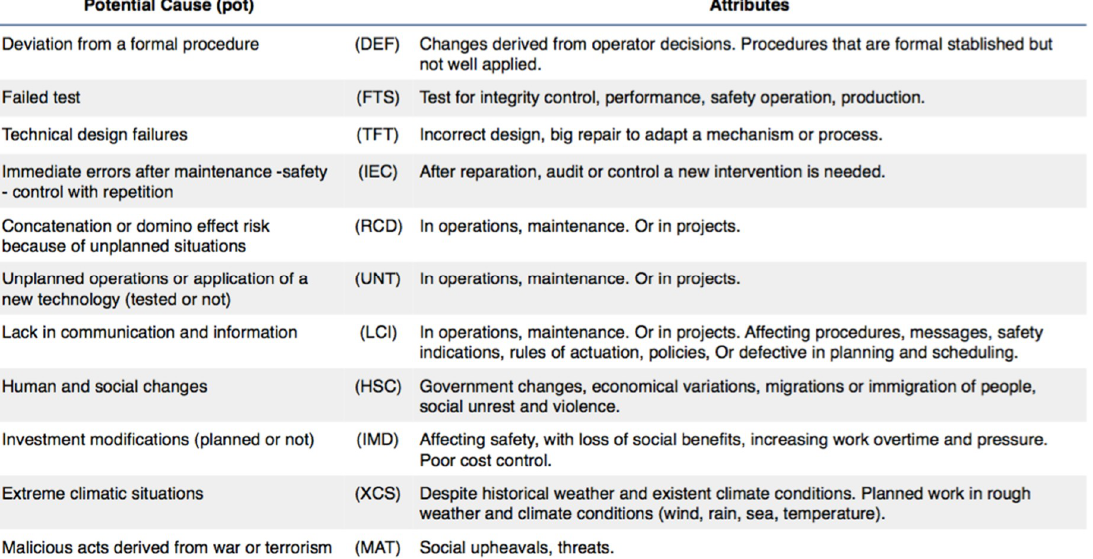
Figure 8. Potential causes (pot) and attributes defined in the Statistical Risk Control (SRC) methodology.